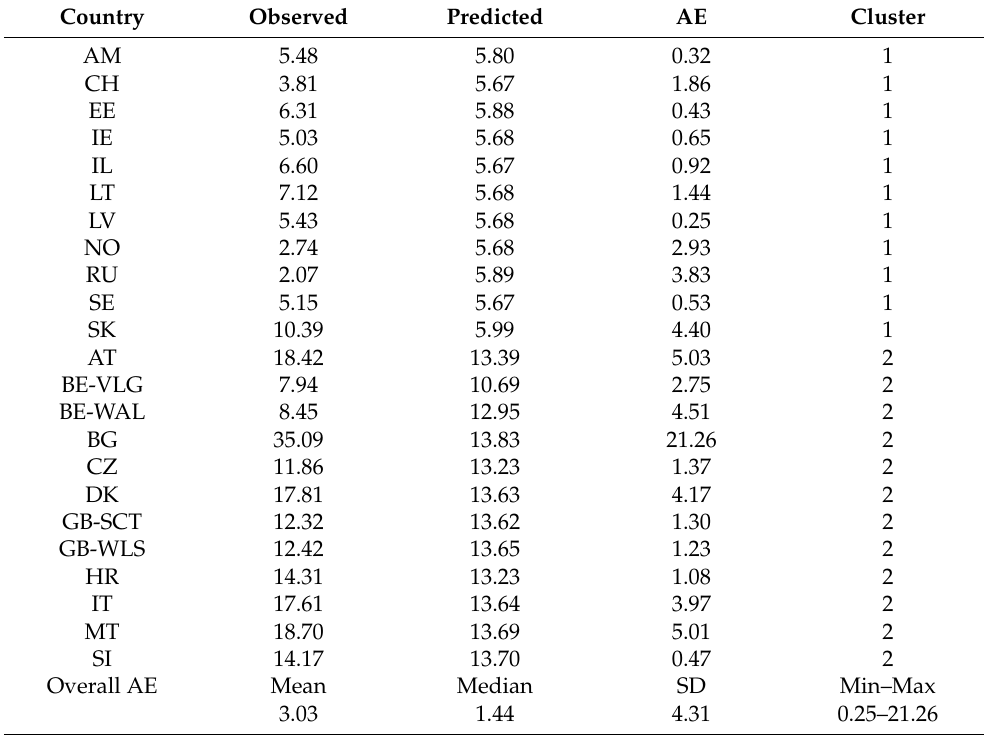
Table 5. Comparison between 2017/18 estimates and observed prevalence (%) among girls. Country